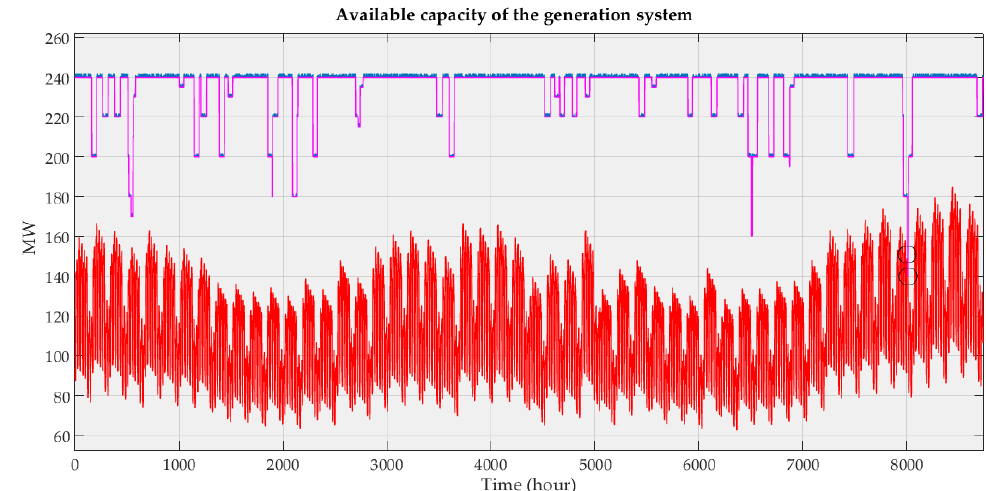
Figure 9. Simulation of the output power from wind farm for the sampling year.